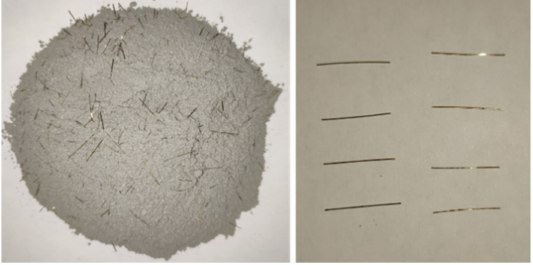
Figure 10. UHPC premix and straight steel fibers.